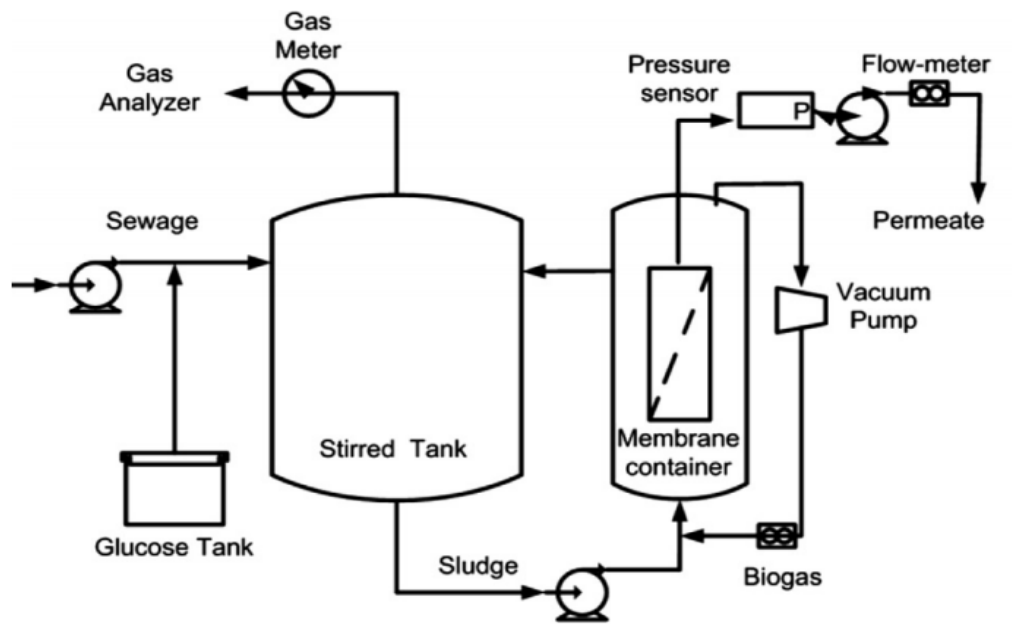
Figure 10. Pilot scale AnSMBR unit for municipal wastewater treatment, as presented by D. Martinez-Sosa et al. [117].